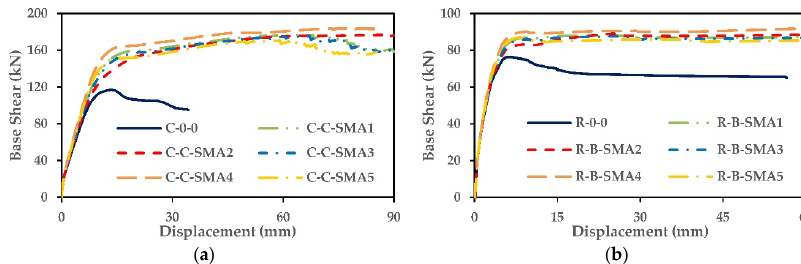
Figure 7. Pushover curves: ( a ) Columns of Group1; ( b ) columns of Group2.